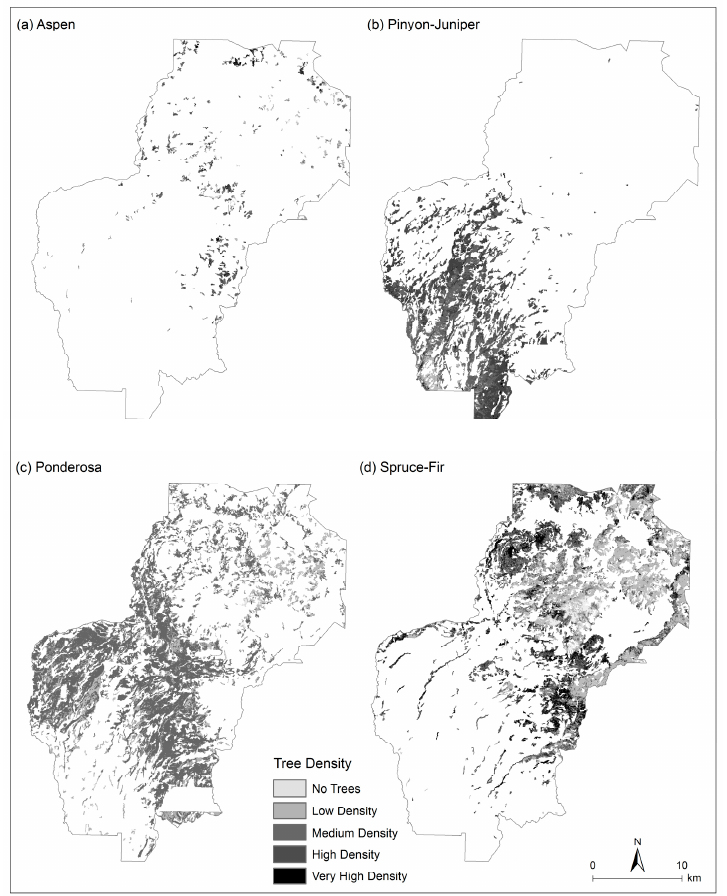
Figure 4. Predicted tree density maps by vegetation types: ( a ) Aspen, ( b ) Piñon-Juniper, ( c ) Ponderosa, and ( d ) Spruce Fir. (No trees: 0 trees, Low density: 1–100 trees/hectare, Medium density: 101–500 trees/hectare, High Density: 501–1000 trees/hectare, and Very high density: more than 1000 trees/hectare) in the Southwest Jemez Mountains, Sandoval Co., NM, USA.